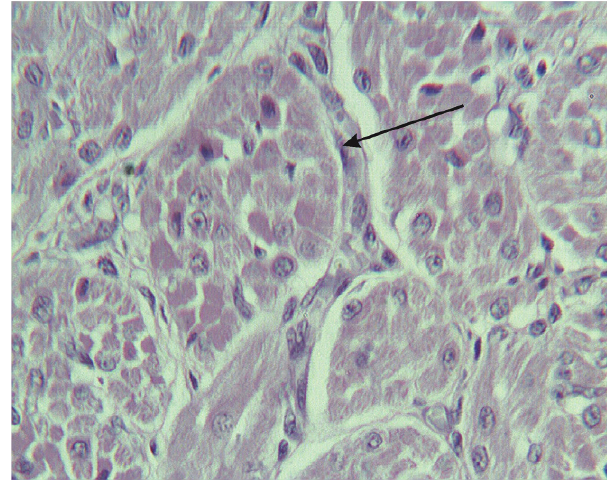
Figure 3 - Coagulative necrosis.